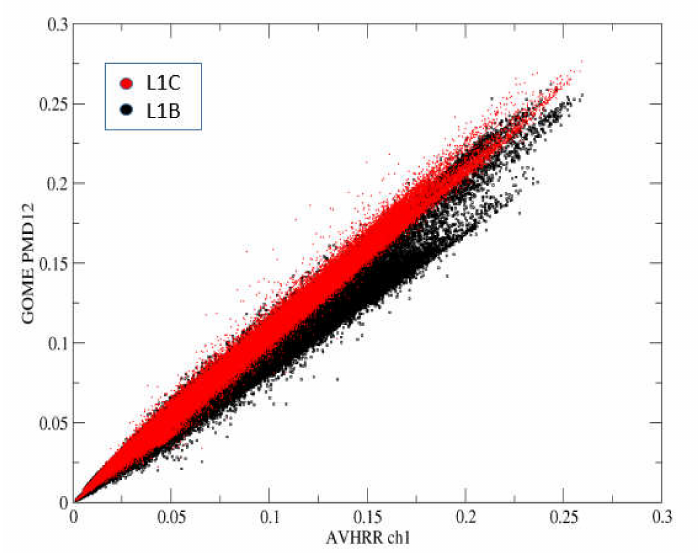
Figure 3. PMD-12 reflectance before (from L1B) and after (from L1C) radiometric correction as a function of colocated AVHRR reflectance in channel 1 for one orbit of acquisition, the 16 October